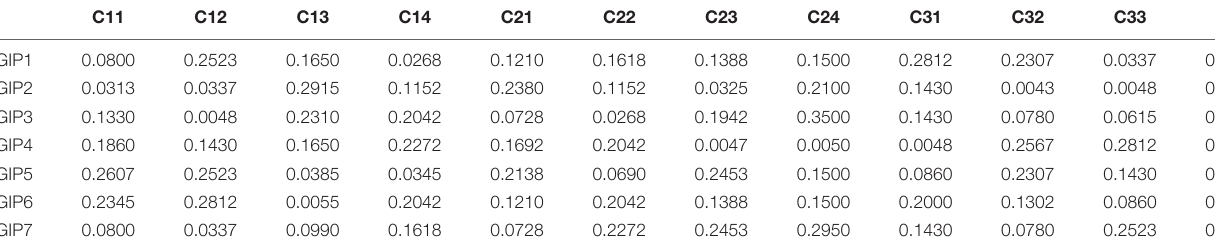
TABLE 6 | The matrix of defuzzification given by AHEM experts.